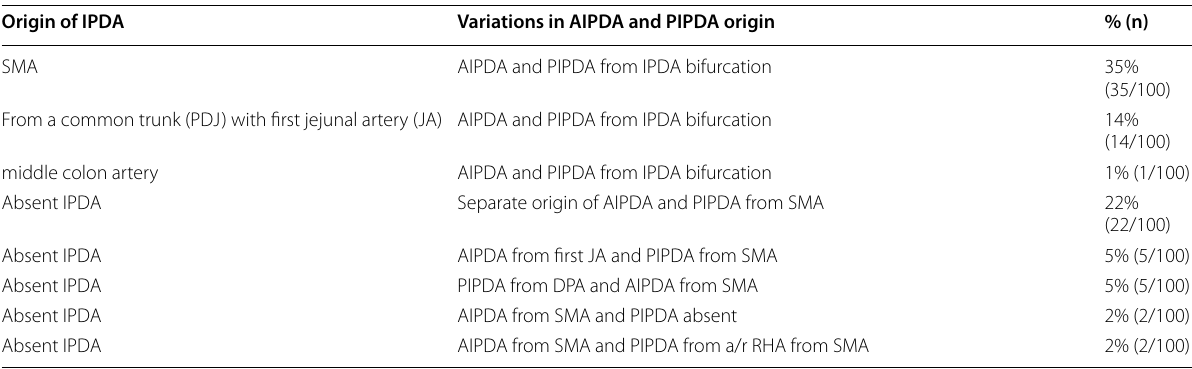
Table 4 The major origin of IPDA, AIPDA, and